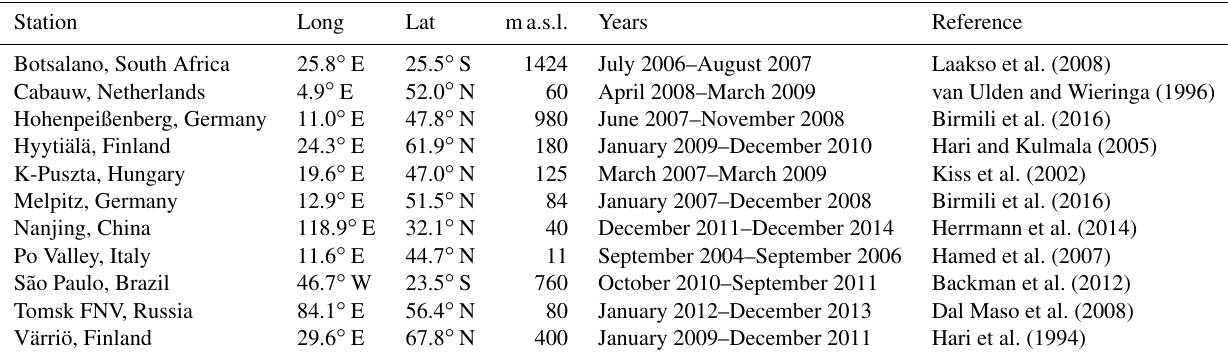
Table 2. Description of measurement sites for model-versus-observation evaluation. Station